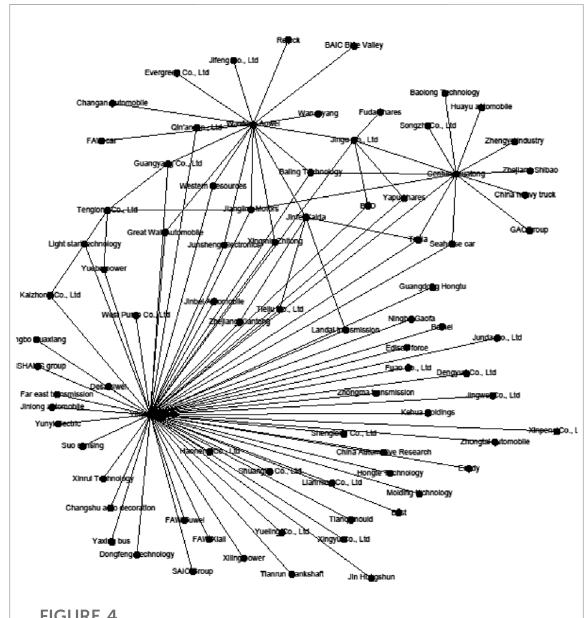
FIGURE 4 NetworkdiagramofChina ’ sauto fi nancemarketinthefourth quarter of